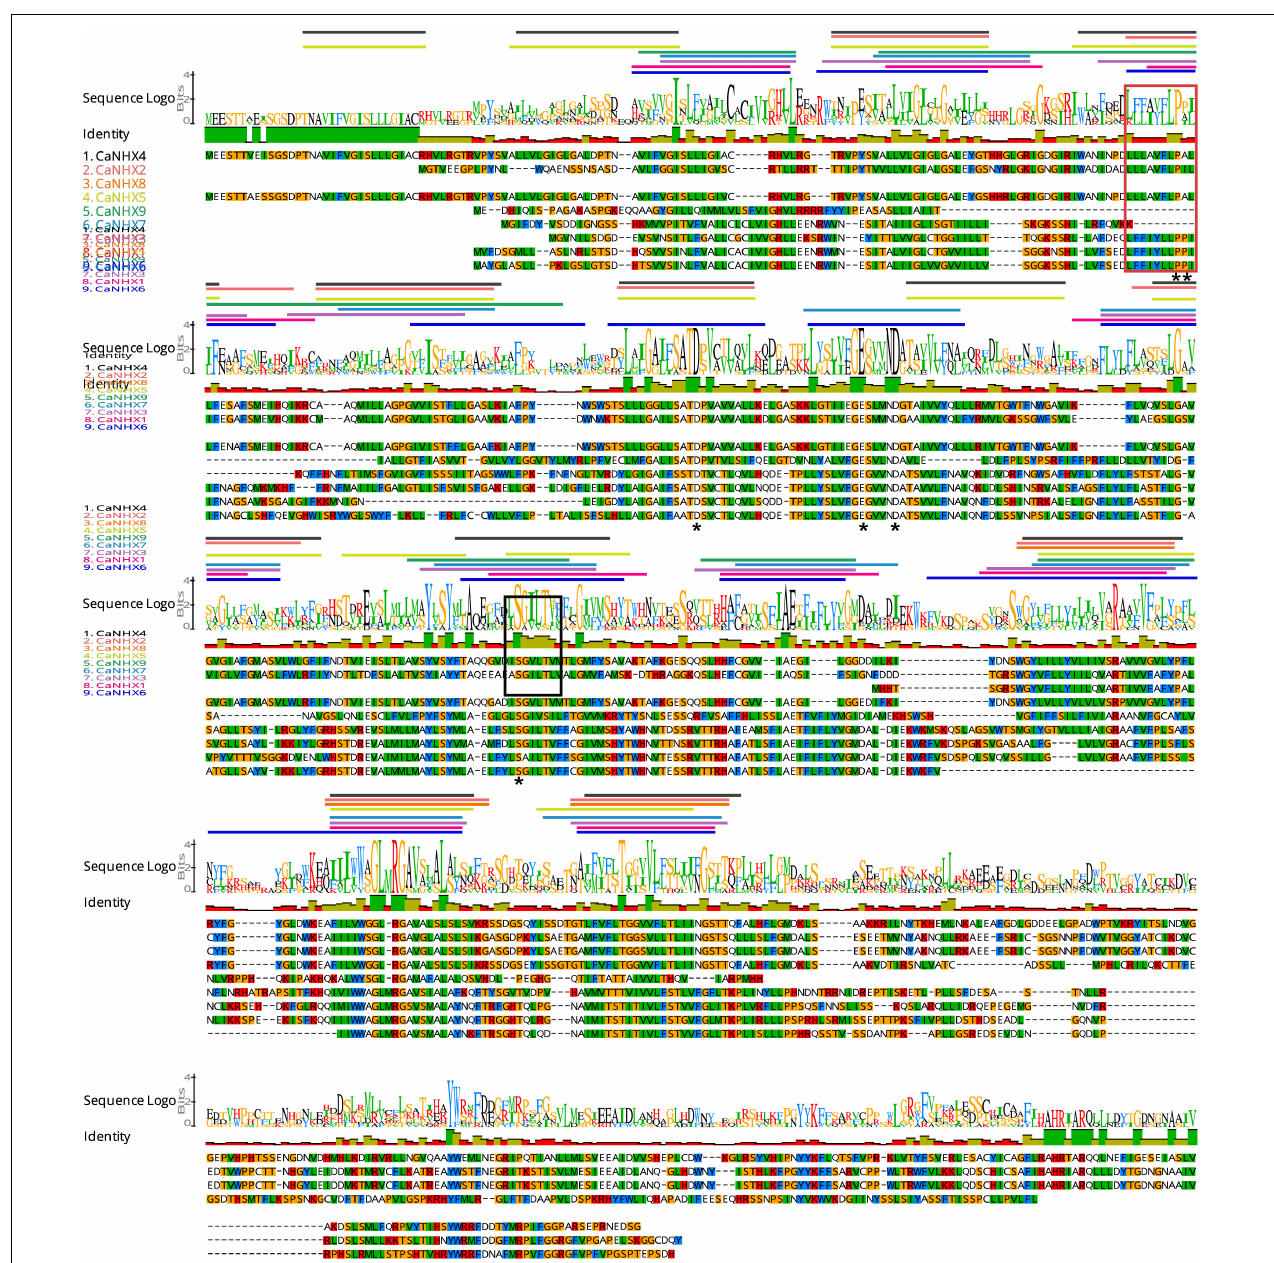
FIGURE 3 | Sequence alignment of CaNHX Gene in